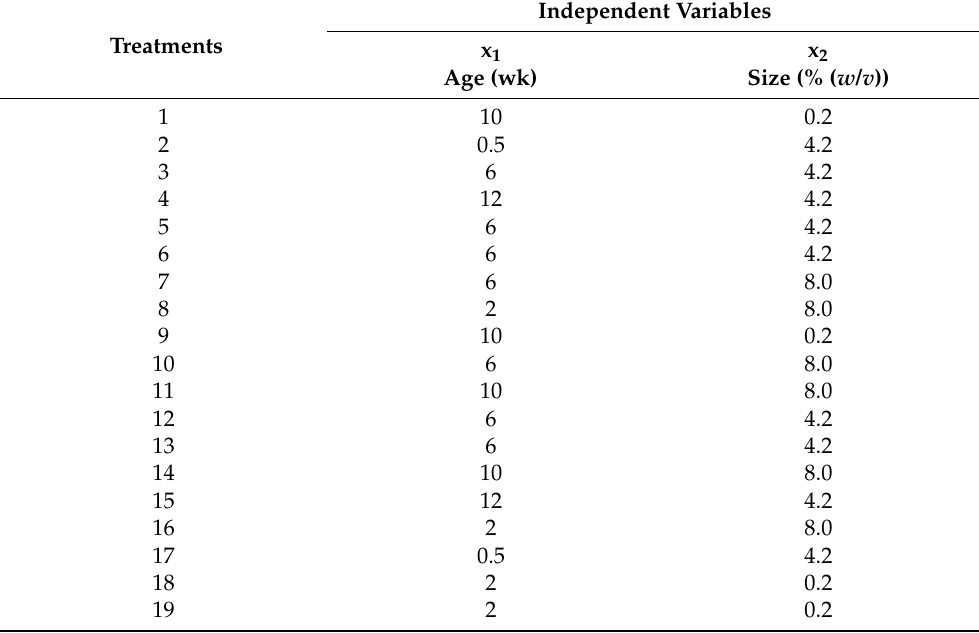
Table 6. Fractional factorial design for the 2 independent variables (X 1 : inoculum size and X 2 : age). Independent Treatments